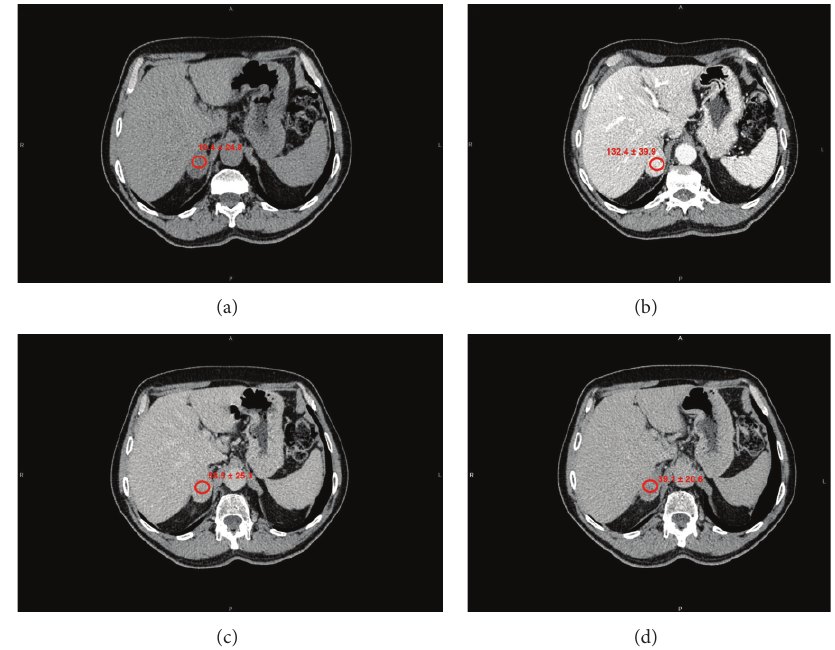
Figure 2: Lipid-poor adenoma. (a) Unenhanced attenuation values: 19, 4 ± 24 ,8 HU. (b) Portal-phase attenuation values: 132, 4 ± 39 ,9 HU. (c) 5 minutes attenuation values: 58, 5 ± 25 ,3 HU. (d) 15 minutes attenuation values: 39, 1 ± 20 ,6 HU. Absolute percentage wash-out at 5 󸀠 :65,3%. Relative percentage wash-out at 5 󸀠 :55,8%. Absolute percentage wash-out at 15 󸀠 :82,5%. Relative percentage wash-out at 15 󸀠 :70,4%.